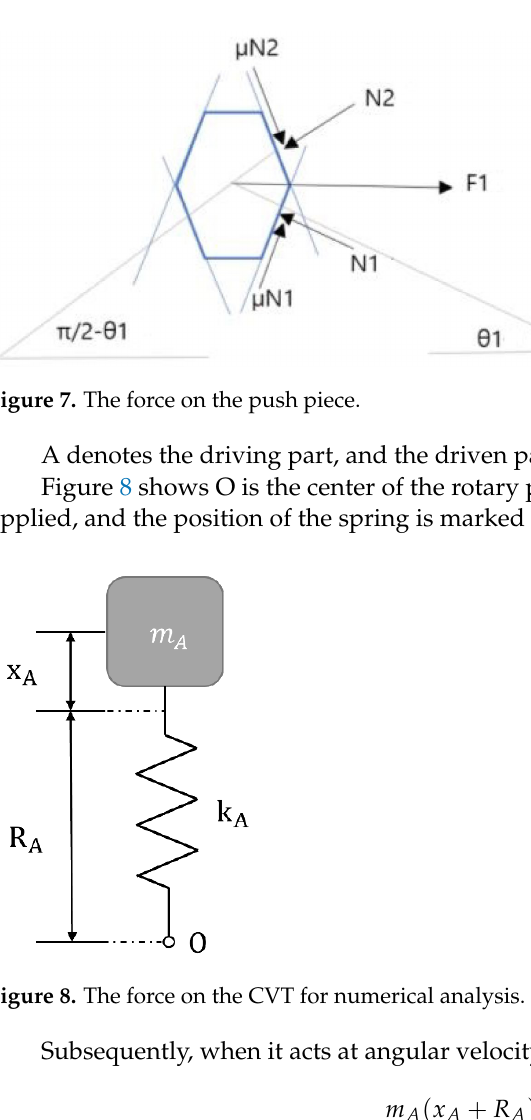
Figure 6. The principle of the design program for improving CVT performance.